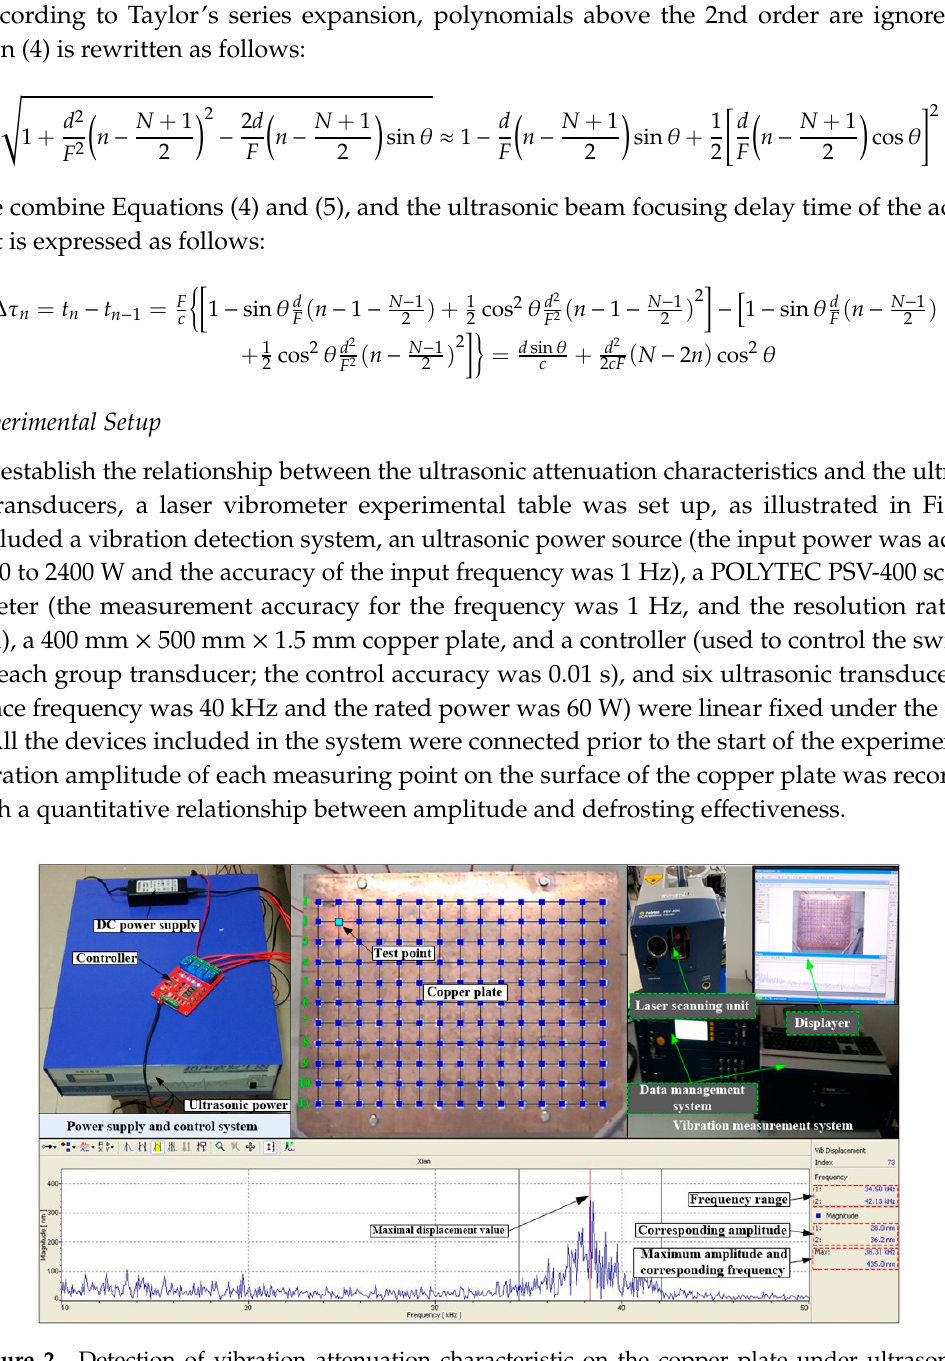
Figure 2. Detection of vibration attenuation characteristic on the copper plate under ultrasonic array excitation.